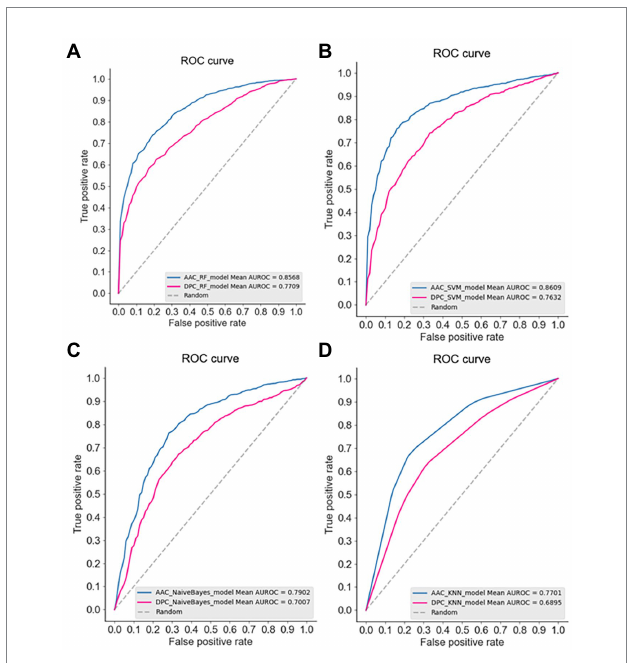
FIGURE 1 The receiver operation characteristic (ROC) curve of the four machine learning models using AAC and DPC descriptors. (A) Random forest, RF; (B) SVM; (C) Bayes; (D)